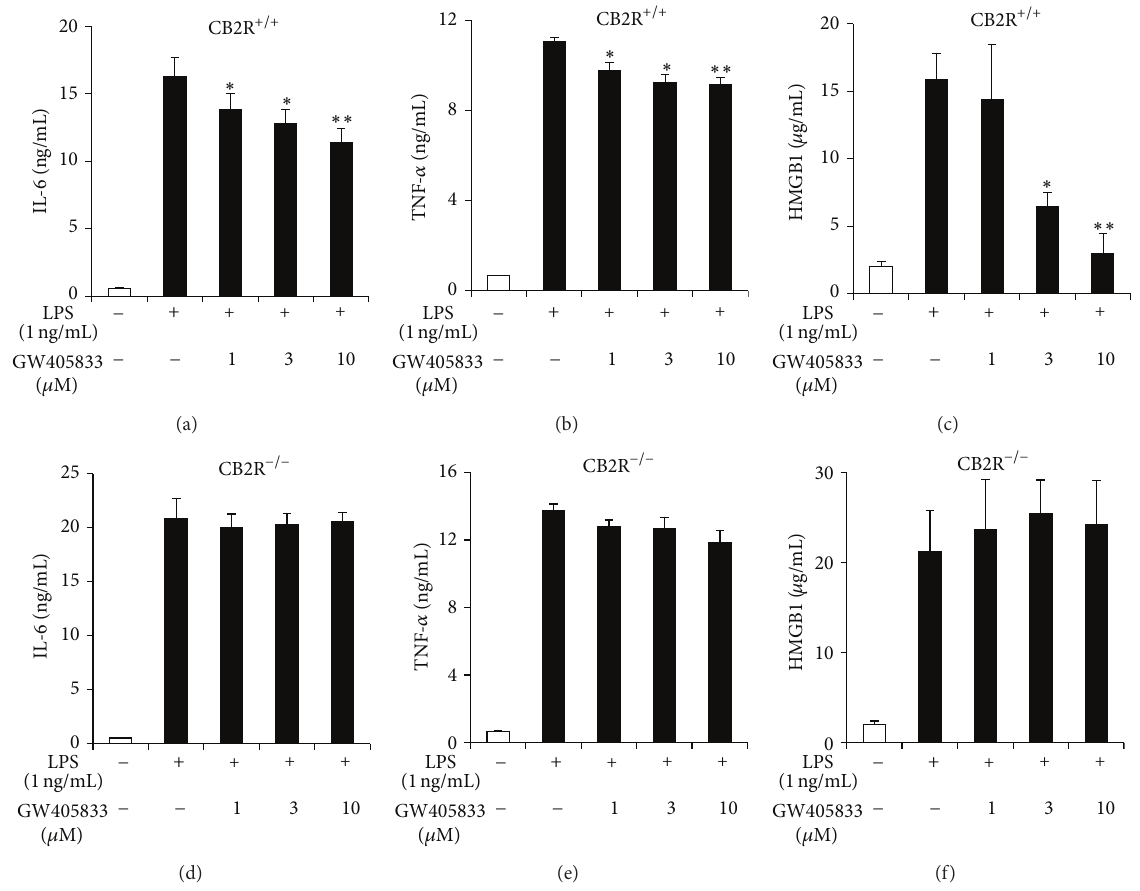
Figure 4: CB2R is critical for the inhibitory role of GW405833 on LPS-triggered IL-6, TNF- 𝛼 , and HMGB1 production in macrophages. (a)– (c) Peritoneal macrophages isolated from CB2R +/+ mice were treated with vehicle or LPS (1ng/mL) in the absence or presence of GW405833 (1–10 𝜇 M) for 24h. The levels of IL-6, TNF- 𝛼 , and HMGB1 in the supernatants were detected by ELISA. (d)–(f) Peritoneal macrophages isolated from CB2R −/− mice were treated as described in (a)–(c). The levels of IL-6, TNF- 𝛼 , and HMGB1 in the supernatants were detected by ELISA. Data are means ± SD ( 𝑛 = 3 ), ∗ 𝑃 < 0.05 , and ∗∗ 𝑃 < 0.01 versus